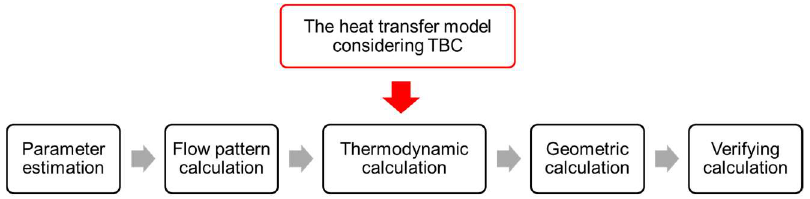
Figure 4. Calculation process of turbine aerothermodynamics, considering cooling with TBCs.